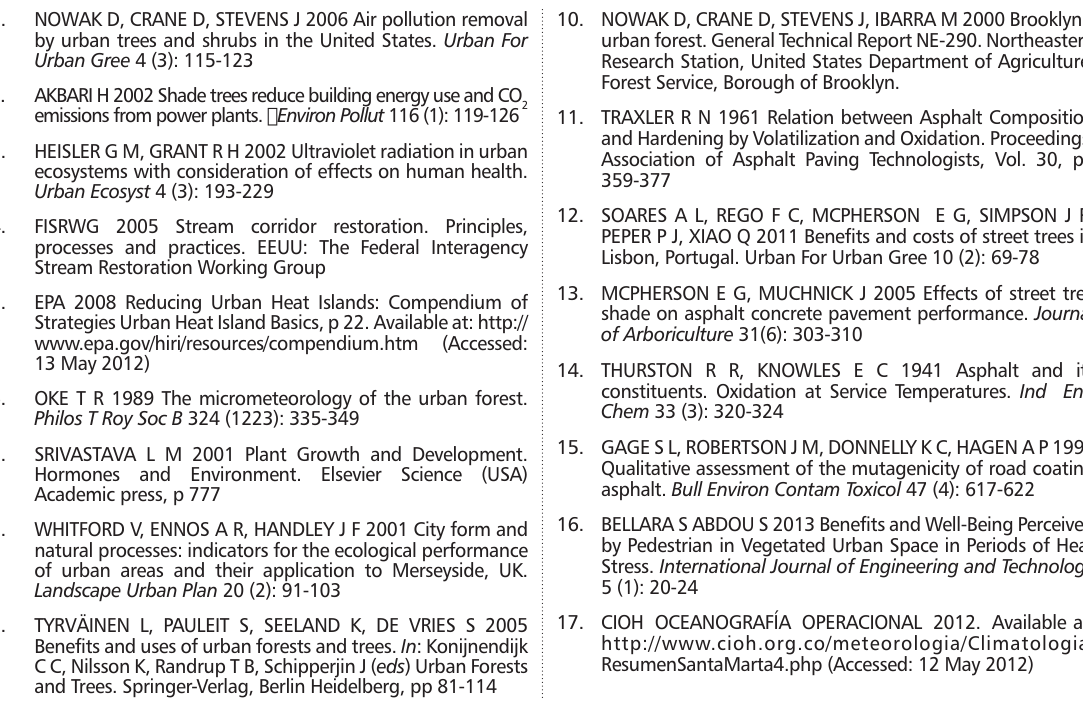
For urban surfaces (sidewalks) we found a range of 50ºC between the lowest value (26ºC under shadow effect) and the highest value (77.2ºC under direct sunlight), conditions that can generate positive effects on heat islands and, in the case of asphalt pavements, even a control of toxic vapours and increase in life cycle durability. Honey mesquite ( Prosopis juliflora) , Redwood tree ( Platysmincium pinatum ) and Rain tree ( Enterolobium ciclocarpum ) trees have the most translucent shadows most likely due to nictinastic